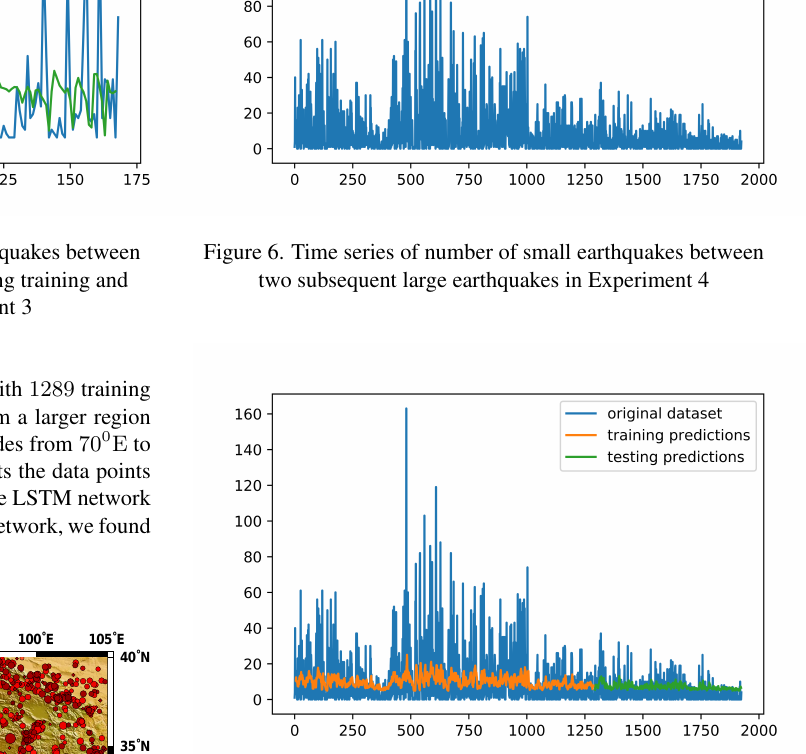
limitation of instrumental capability to capture lower